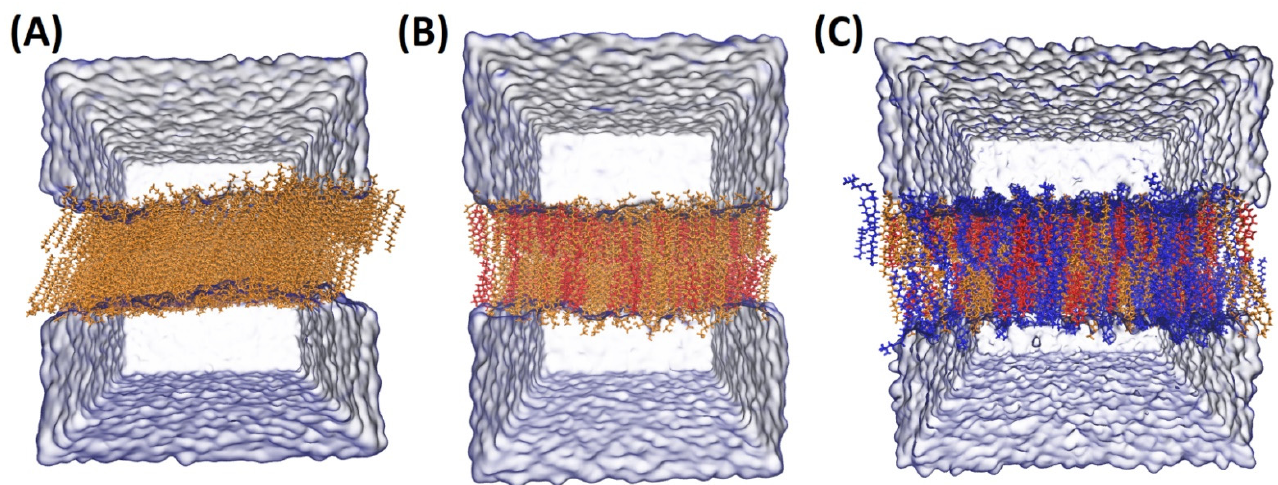
Figure 1. Snapshots of membrane MD systems. In panels ( A ) DPPA, ( B ) Chol/DPPA 1:1 ( C ) POPC/Chol/SAPA 5:3:2 (molar ratios) are shown. Molecules are colored according to the following rule: orange is PA component, red is cholesterol, and blue is POPC lipid molecules. As periodic boundary conditions were applied, the water molecules are organized with respect to periodic repetition of the system (gray/light blue).